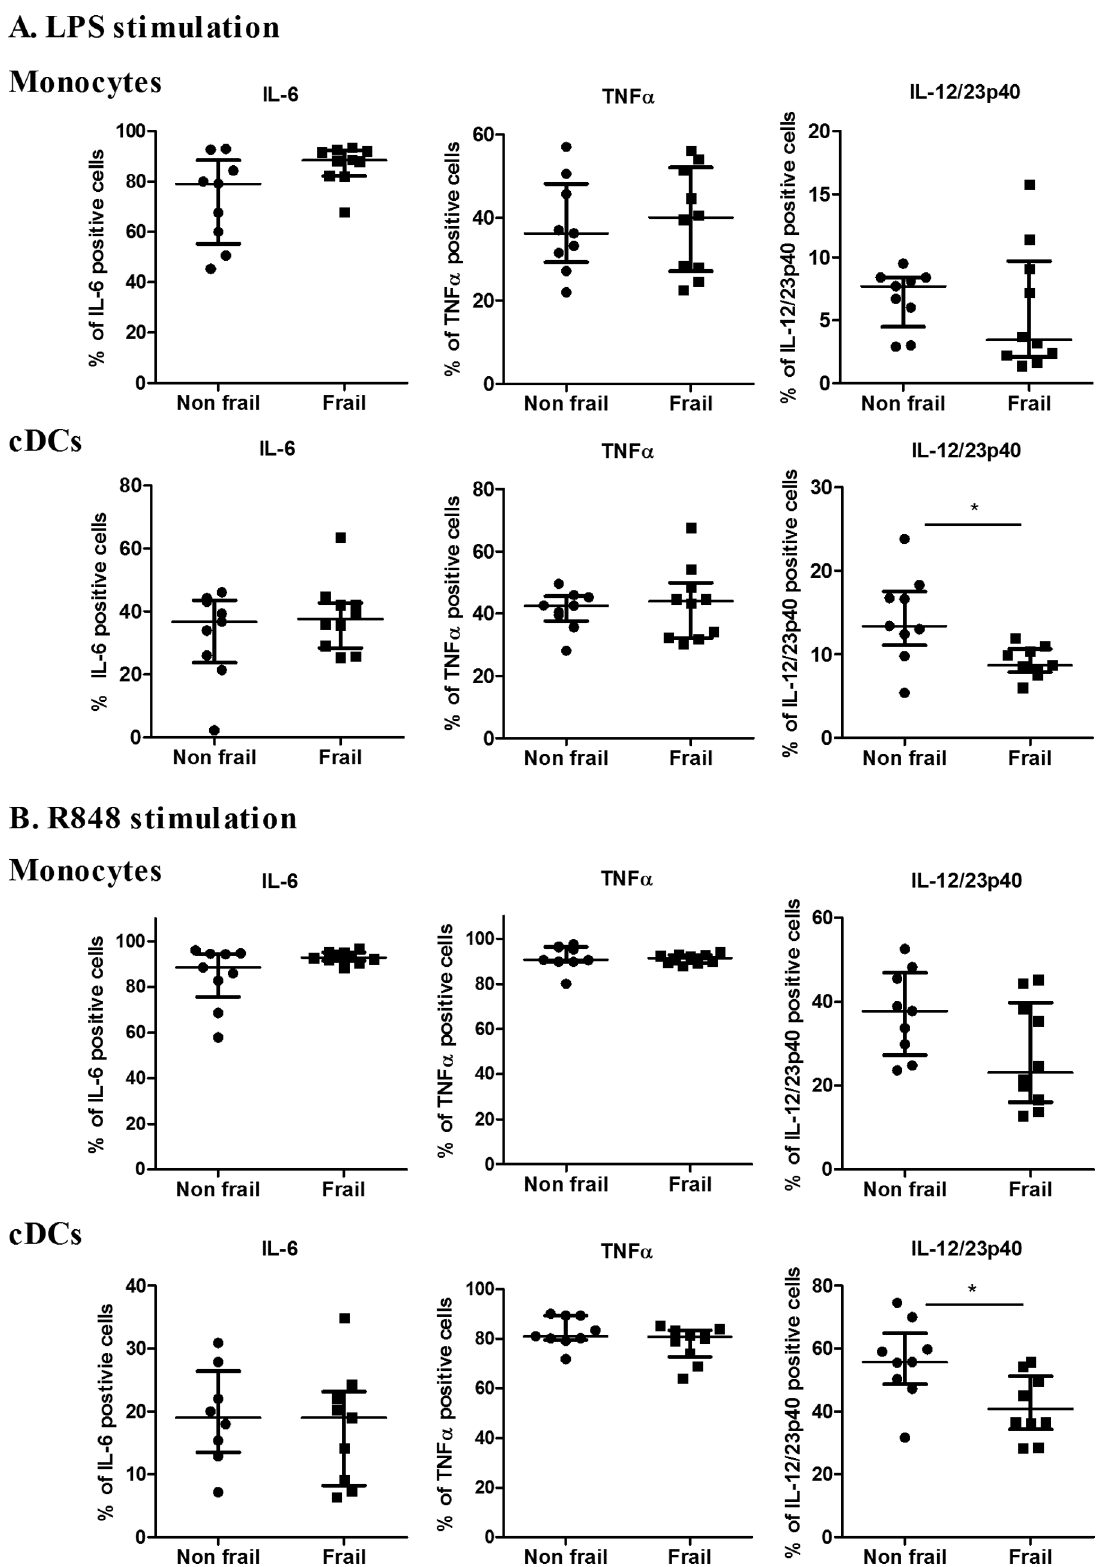
Figure 5. Intracellular cytokine staining of cDCs and monocytes from non frail and frail old subjects. Whole blood cells were stimulated with (A) LPS or (B) R848 during 5 h in presence of brefeldin A. Percentage of IL-6 + , TNF a + and IL-12/23p40 + monocytes and cDCs are shown. The bars represent median values 6 interquartile range. *p , 0.05.